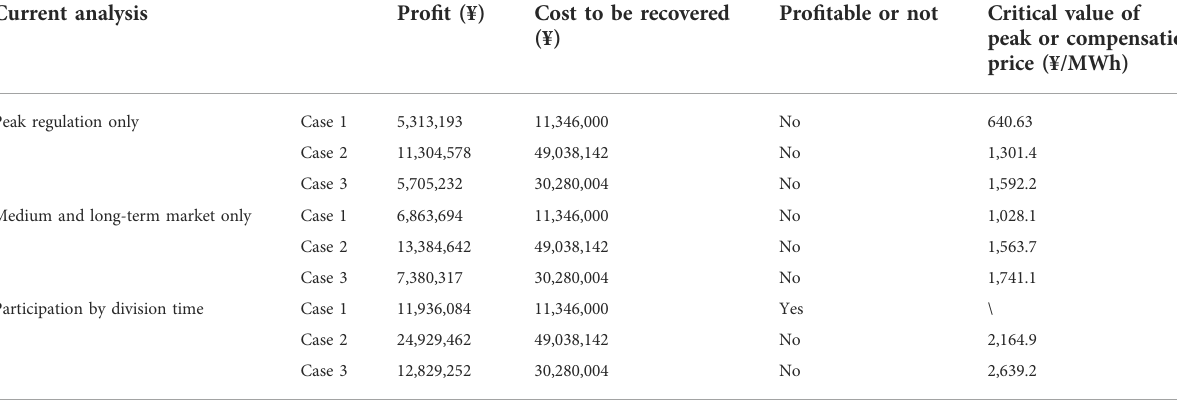
TABLE 3 Summary of pro fi t of participation in current electricity markets.